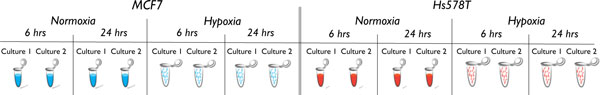
Study of breast cancer cell lines. Two cultures from two breast cancer cell lines (low-invasive MCF7 and high-invasive Hs578T) were treated with two oxygen levels (normoxia, hypoxia) for two periods of time (6 and 24 hours). We refer to each combination of these treatments as condition. Separate cultures were grown in each condition, and therefore the experiment had a 3-way factorial experimental design.